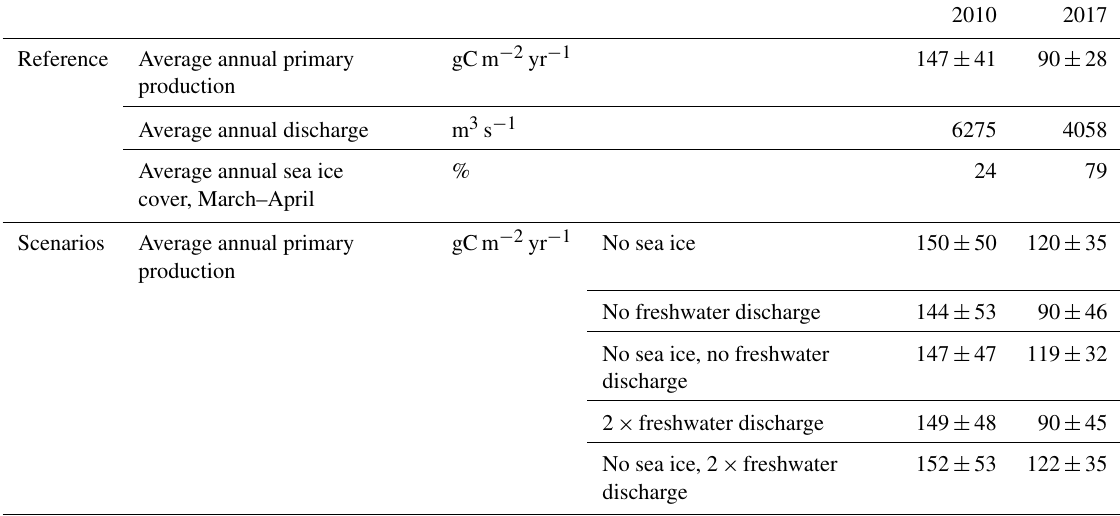
Table 1. Characteristics of the reference model runs of 2010 and 2017 and the annual average NPP in the bay obtained from scenarios runs with changes in the sea ice cover and the freshwater discharge (Figs. 8 and 9). SD is the standard variation between the different model grid cells.